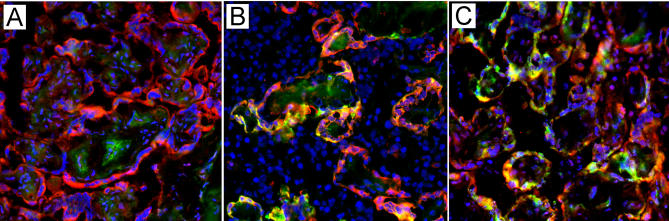
Immunofluorescence of Placental Cryosections from First-Time Mothers Showing VEGFR1 Extracellular Domain (Green), Trophoblast (Red), and Nuclear DNA (Blue)All fields are 200X magnification. Cryosections from (A) PM-negative normotensive pregnancy; (B) PM-positive normotensive pregnancy with intervillous inflammation; (C) PM-positive hypertensive pregnancy.